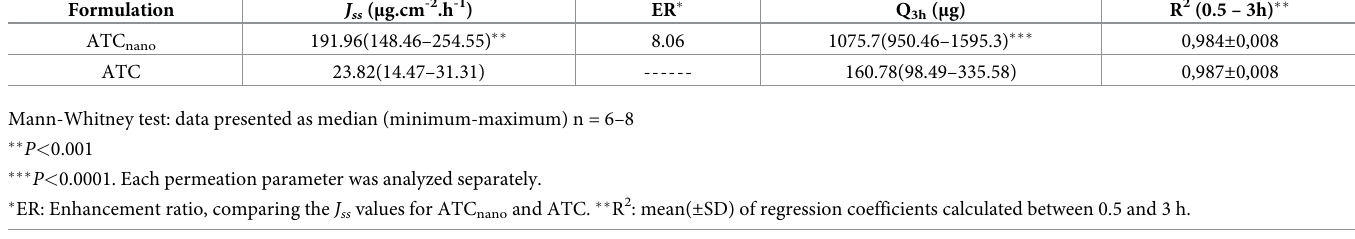
18] and was indicative of homogeneity of the nanoparticles. Local anesthetics have been tested in different kind of cells, as and fibroblasts, neuroblas- toma, mesenchymal stem, keratinocytes [18,31–33]. The immortalized human keratinocytes (HaCaT) have a good proliferative capacity in culture, being used in in vitro studies of cytotox- icity [24,33,34] and other cellular responses to stimulus [35,36]. The MTT assay results showed that encapsulation reduced the toxicity of articaine to HaCaT cells exposed for 1 h and 24 h, which was confirmed by the results of the LIVE/ DEAD 1 assay. The fact that the cytotoxicity of articaine was greatly reduced by its encapsula- tion is an important finding, since this local anesthetic has been associated with cell injury and paresthesia after local injections in dental procedures [2,8].